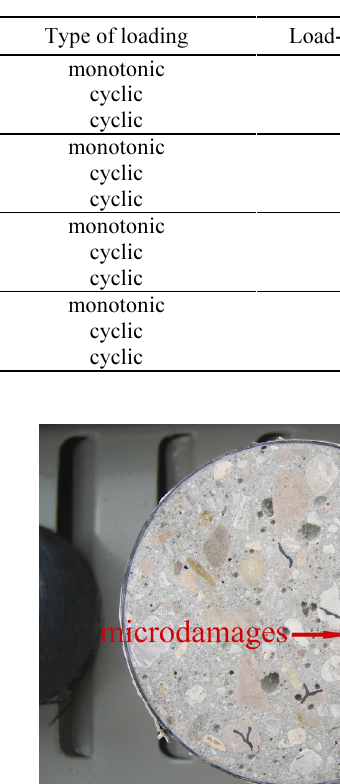
Table 3 . Tests results – stage I